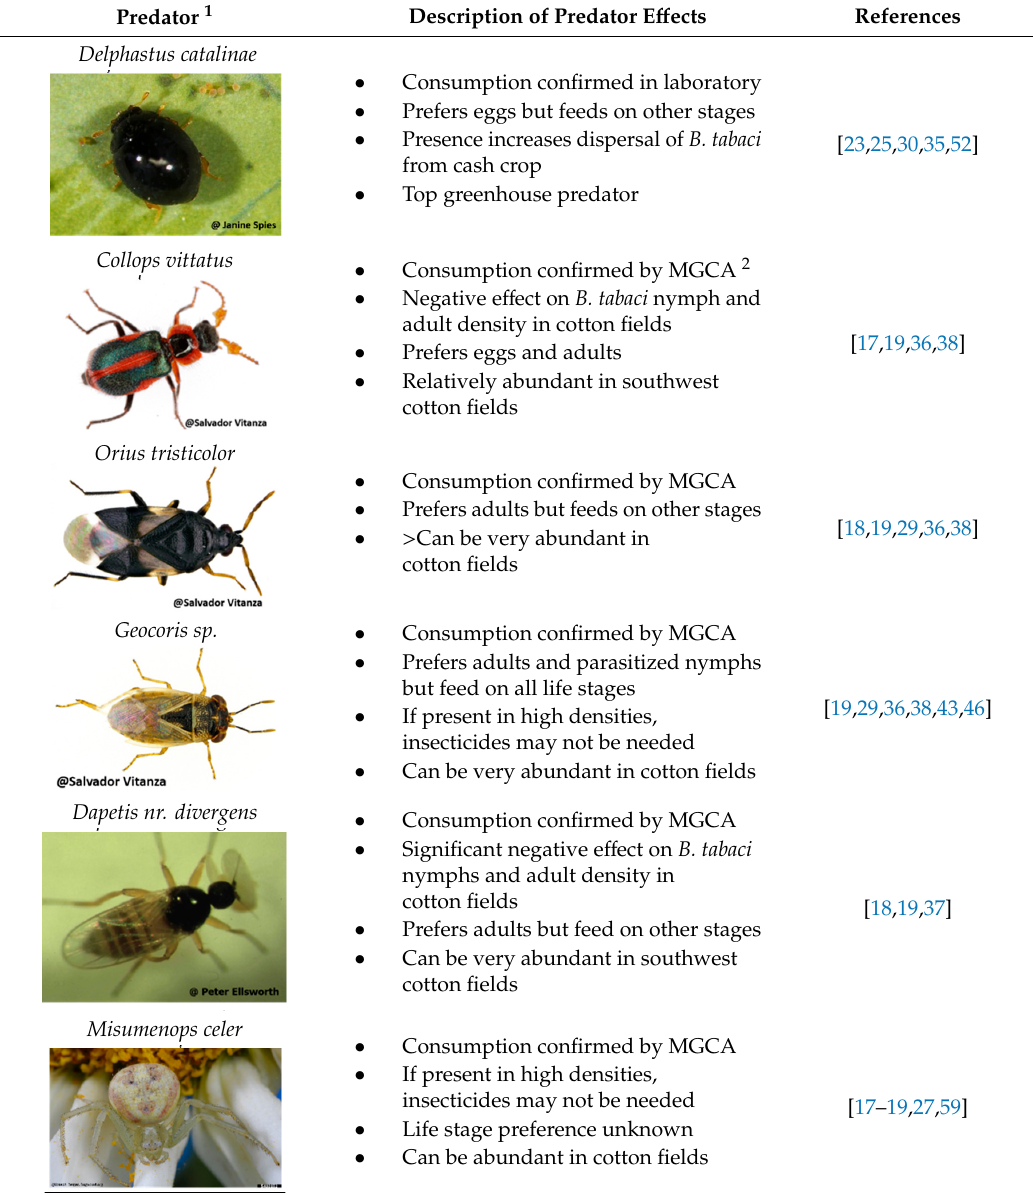
Table 3. Summary of the most abundant and significant predators of Bemisia tabaci in fields and greenhouse conditions.